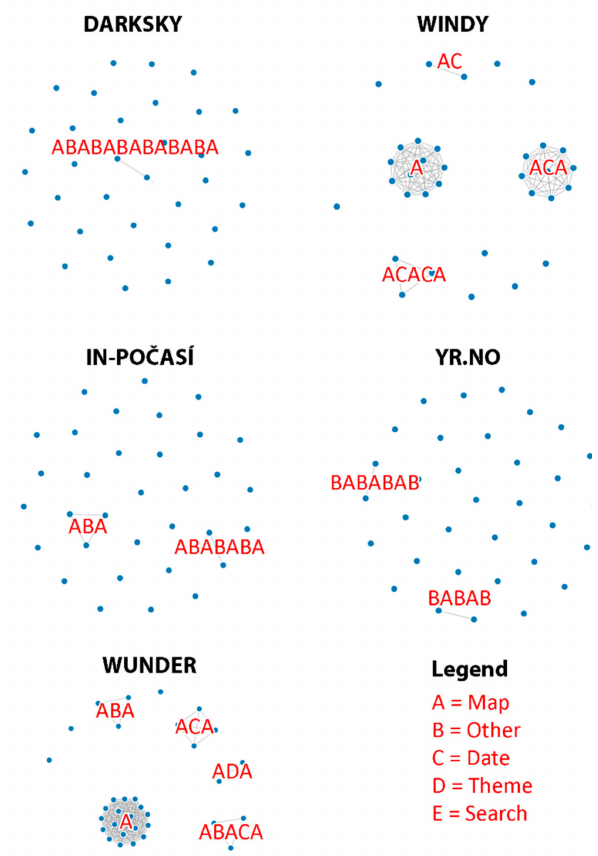
Figure 18. Graphic outcome of the ScanGraph analysis. Each dot represents one respondent Dots connected by an edge form a group based on the same order of visited Areas of